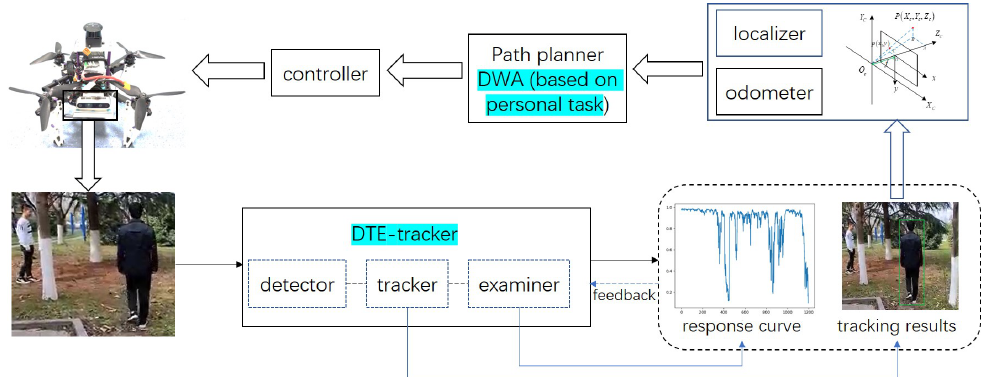
Figure 1. Dynamic Target Tracking and Control Framework of UAV.